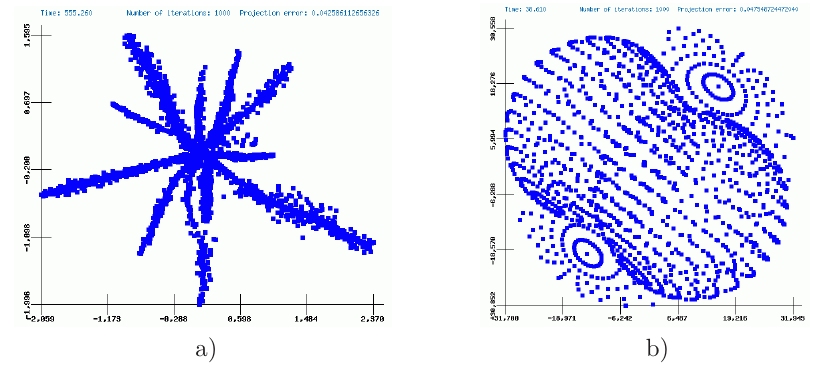
Figure 6. Visualization results (using Relative MDS): projections of the Ellipsoidal (a) and Sphere (b) data sets. The data sets were visualized with 10% of the analyzed